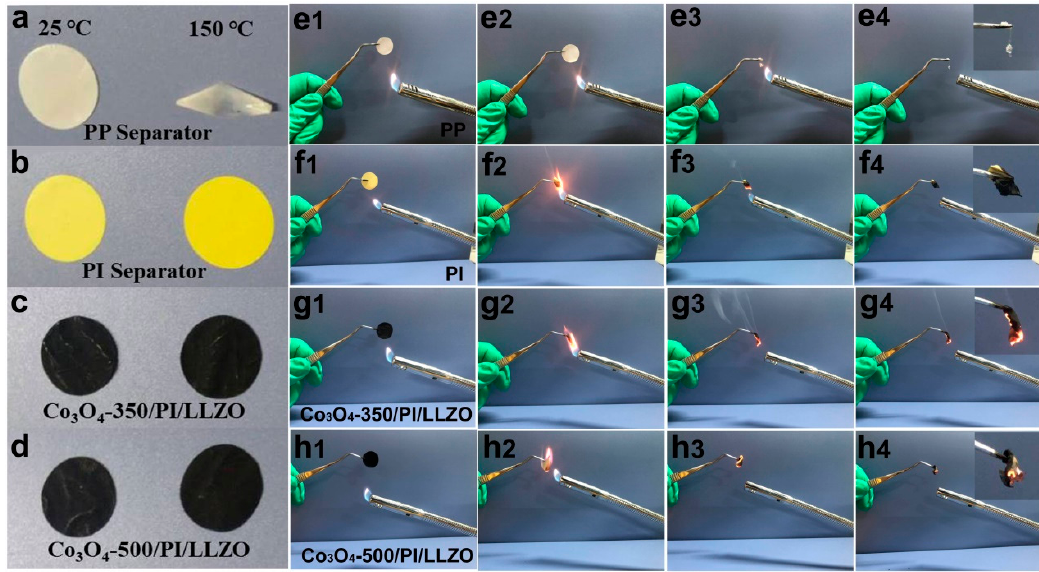
Figure 3. The thermal stability ( a – d ) and Flame-retardant properties ( e – h ) of the polypropylene (PP) separator, polyimide (PI) separator, Co 3 O 4 -350/PI/LLZO separator and Co 3 O 4 -500/PI/LLZO separator. separator, polyimide (PI) separator, Co 3 O 4 -350 / PI / LLZO separator and Co 3 O 4 -500 / PI / LLZO